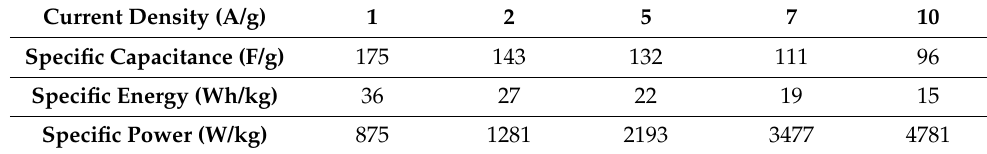
Figure 6. The energy storage performance of the CuSe-TiO 2 -GO||AC-GO||KOH hybrid superca- pacitor, ( a ) CV profile from 0 to 2 V with several scans, ( b ) discharge/charge platforms, ( c ) variation in capacitance with the current rate, ( d ) specific capacitance versus current density. Table 2. The capacitance and specific energy/power values at different current rates.